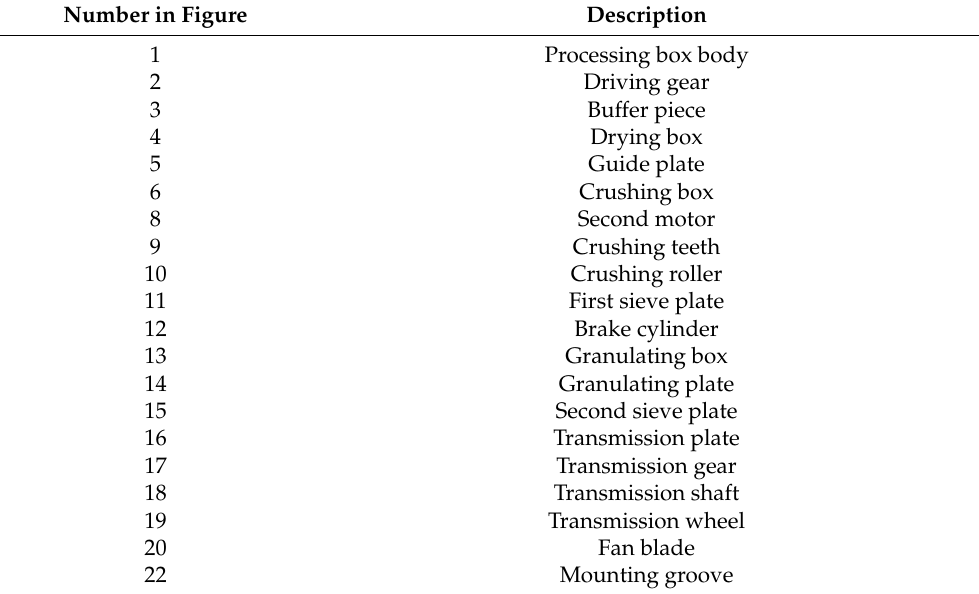
Table A5. An anaerobic partially automated composter from CN112354616A